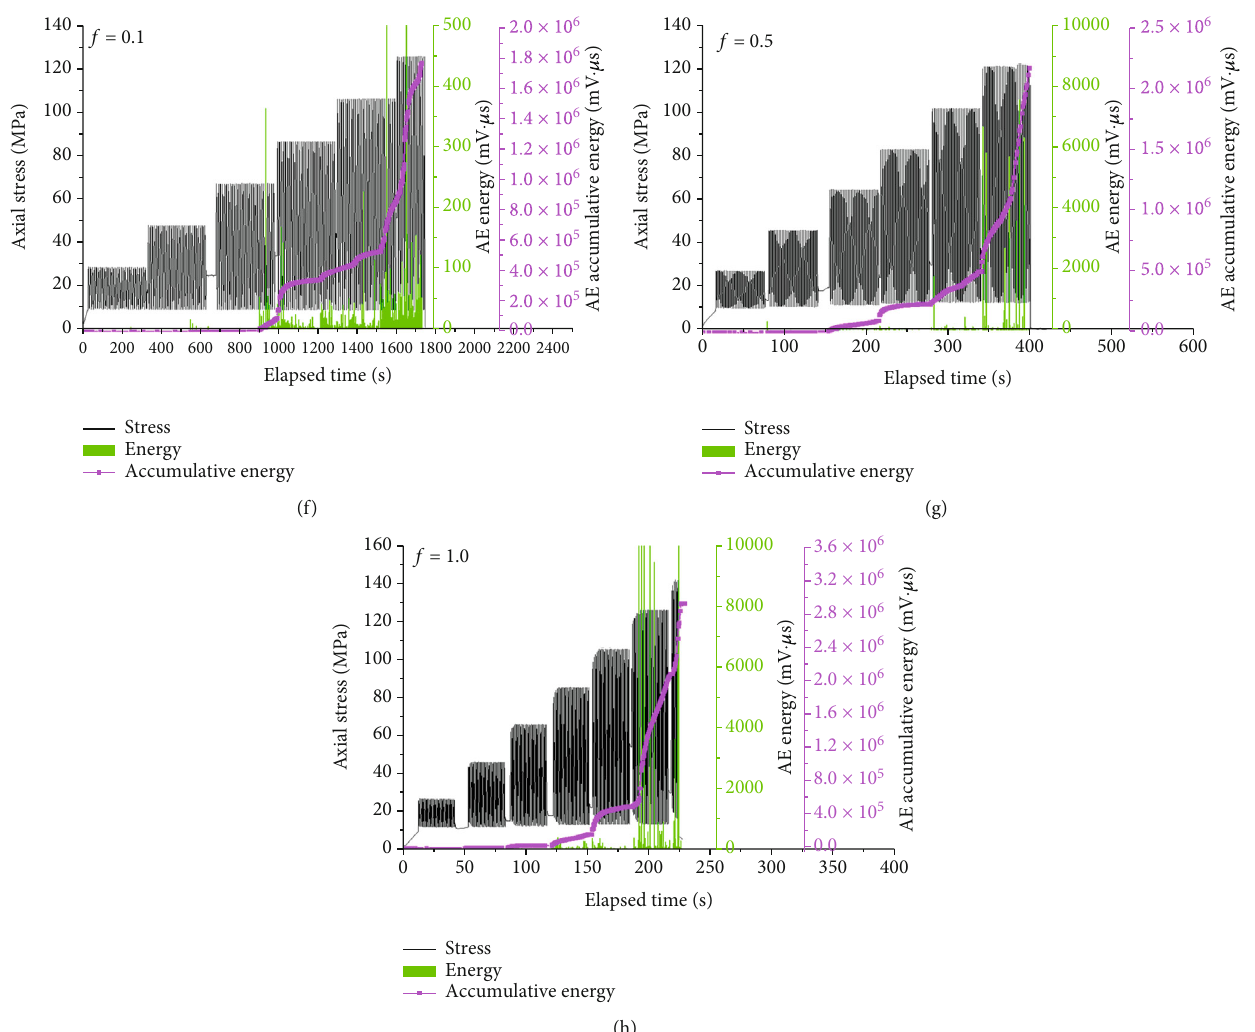
Figure 5: The relationship between the axial stress, AE rate, AE count accumulation, AE energy, AE accumulative energy, and the experimental time for pre fl awed granite under dynamic frequency of 0.04, 0.1, 0.5, and 1.0, respectively. (a – d) Description of AE counts during rock deformation. (e – h) Description of AE energy during rock